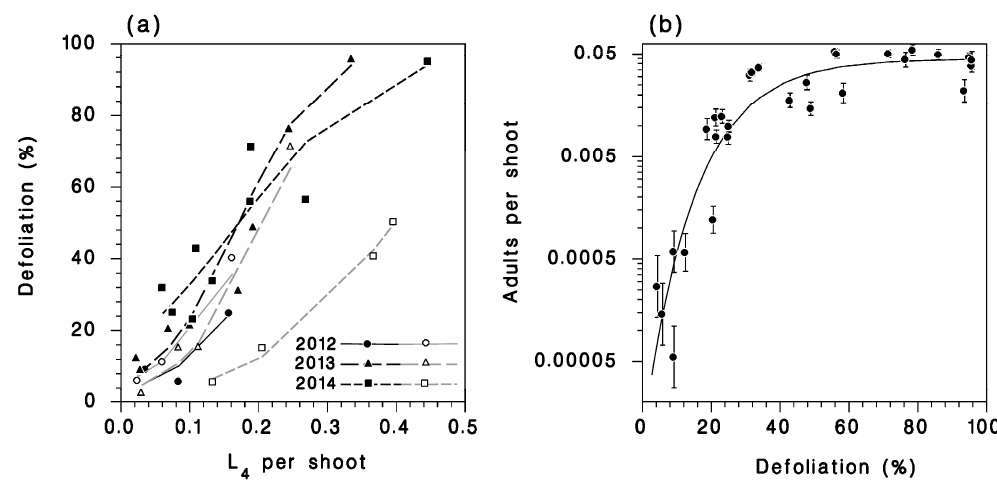
Figure 5. ( a ) Relationship between defoliation of current-year shoots and larval density at the L 4 (lines: Equation (2)), reduced (black lines and closed symbols: Untreated; grey lines and open symbols: Treated with insecticides). ( b ) Relationship between adult density and defoliation. Vertical bars: SEM.